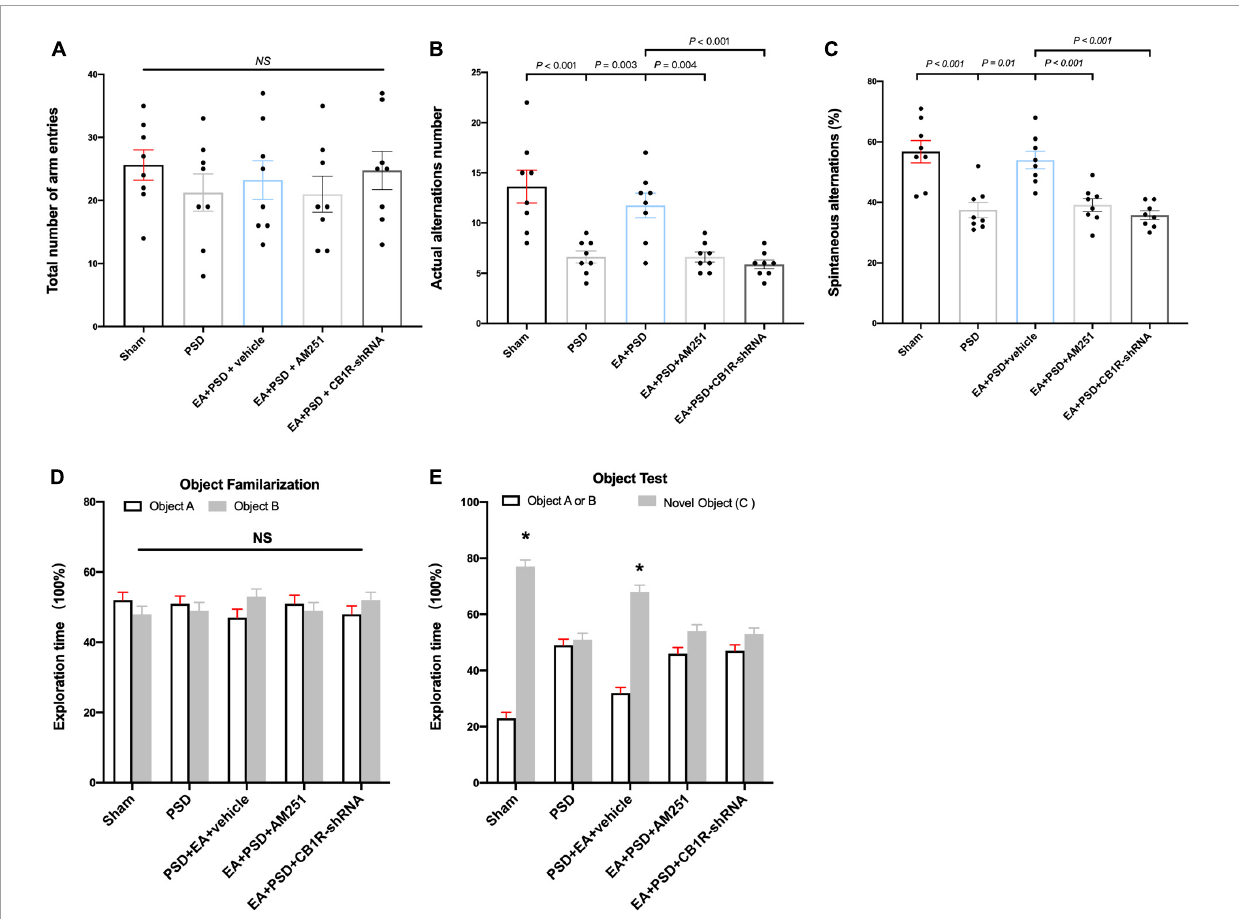
FIGURE6 The improved cognitive outcome produced by EA treatment was reversed by the mutant of CB1R. (A–C) Neither PSD, EA nor CB1R knockdown affected the number of total arm entries (A) . EA treatment significantly improved the exploring outcome of spatial working memory (B) and spatial cognitive ability (C) in Y-maze test, this effect was reversed by the supplementation of AM251 and CB1R-shRNA. (D) The procedure of PSD, EA, AM251 and CB1R-shRNA didn’t alter the time of mice spent exploring two identical object A or object B during the familiarization period. (E) EA treatment increased the time of mice spent exploring familiar object A or B and novel object C during the recognition period, whereas this effect was abolished by the deficiency of CB1R ( n = 8, * P < 0.05 vs. familiar object A or B